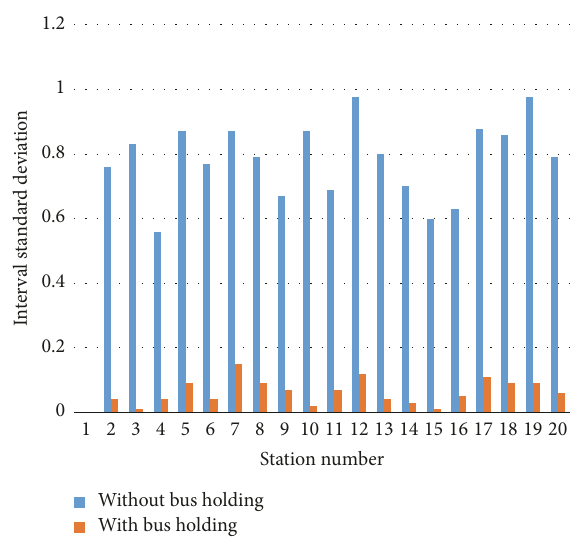
Figure 9: Interval standard deviations along route